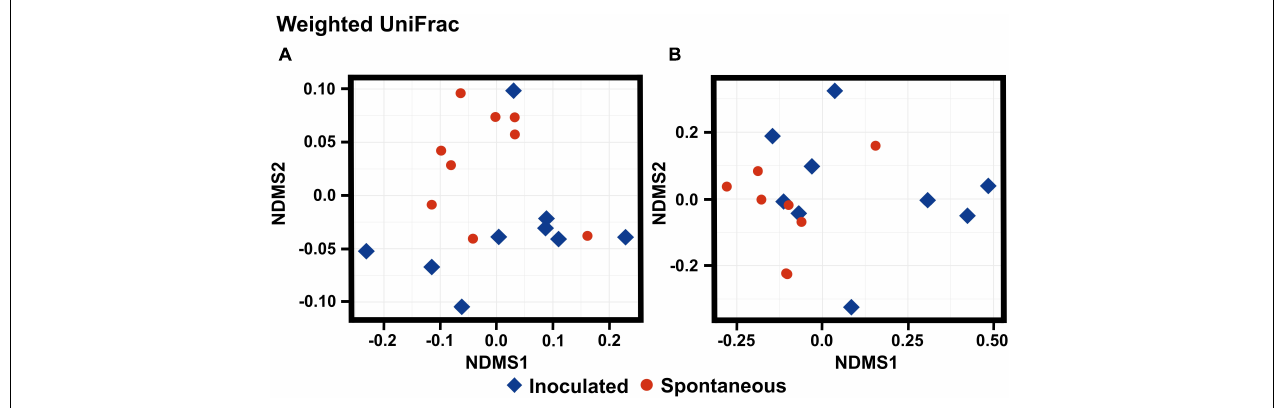
FIGURE 3 | Non-metric multidimensional scaling (NMDS) plots-based (A) on UniFrac weighted distance of the bacterial community structure; (B) an Unifrac weighted distances of the fungal community structure associated with inoculated and spontaneous fermentation practices in the colonche